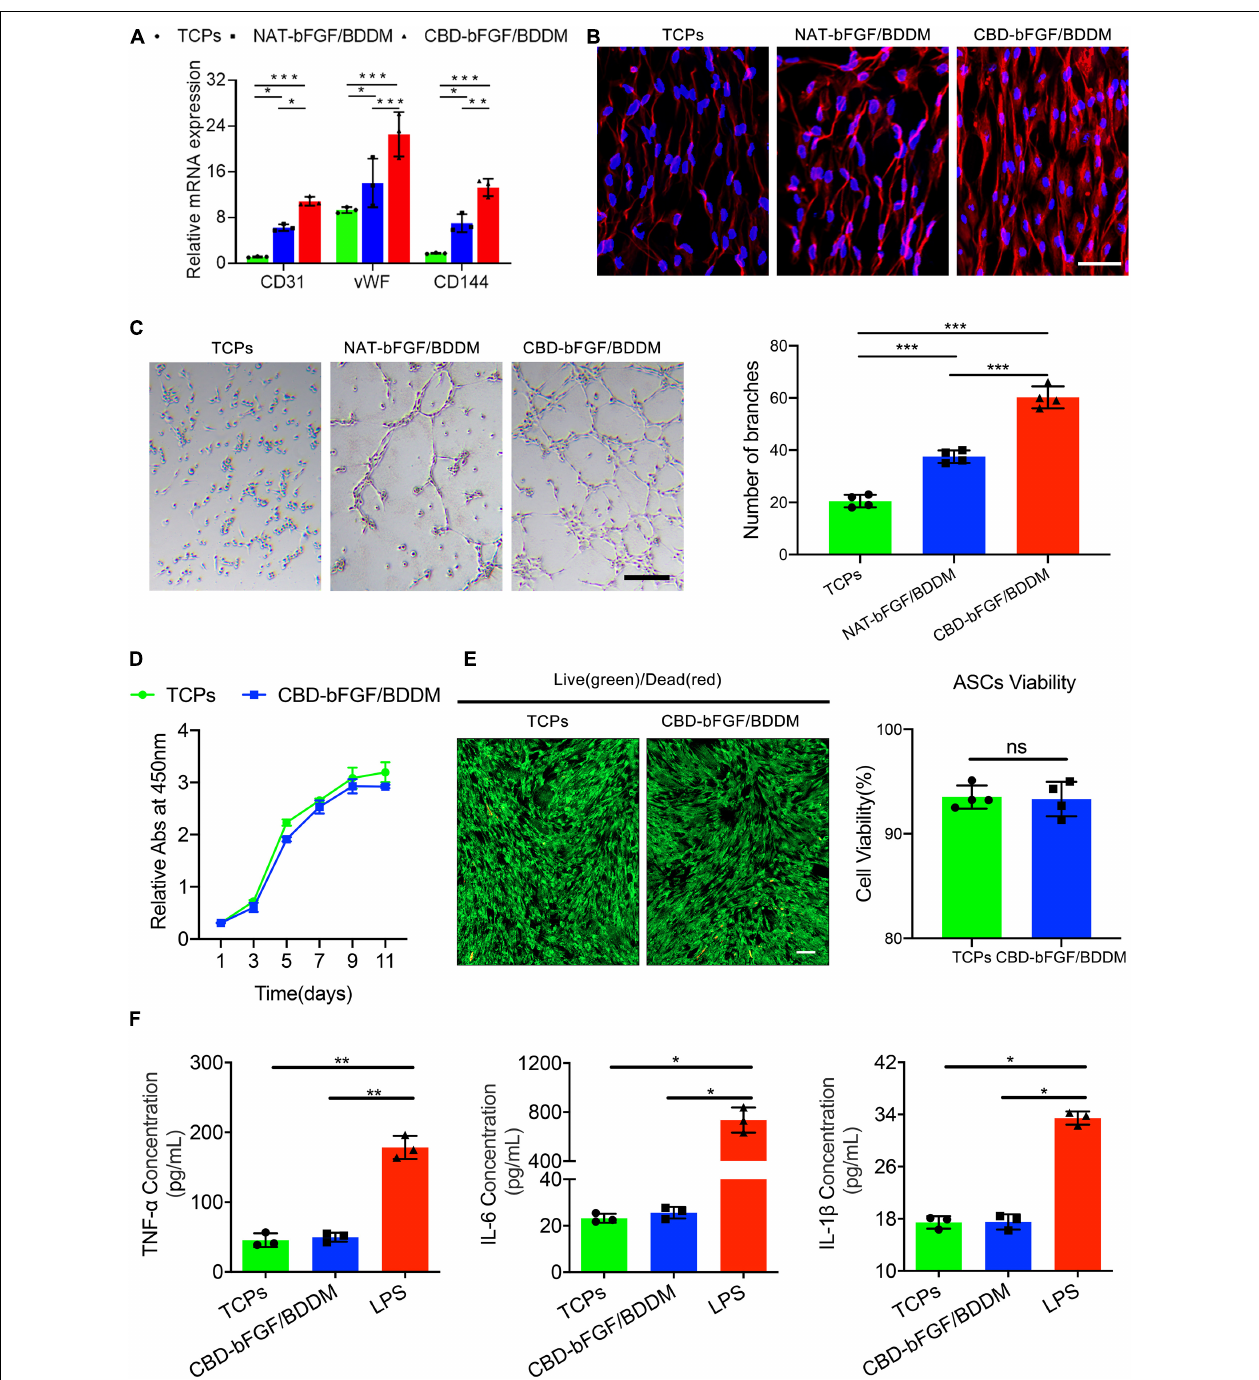
FIGURE 5 | (A) Endothelial cell-specific markers’ (CD31, vWF, and CD144) expression quantified by qRT-PCR demonstrates that natural (NAT)–basic fibroblast growth factor (bFGF)/book-shaped decellularized dermal matrix (BDDM) or collagen-binding domain (CBD)–bFGF/BDDM induced the expression of these endothelial molecular markers. (B) Immunofluorescence staining assays for CD31 expression in the adipose-derived stromal cells (ASCs) cultured with tissue culture polystyrenes (TCPs), NAT-bFGF/BDDM, or CBD–bFGF/BDDM for 10 days. Bar = 50 µ m. (C) Phase-contrast photographs of the differentiated ASCs subsequently plated onto Matrigel for 12 h show more formation of capillary-like structures under the stimulation of CBD–bFGF/BDDM for 10 days. Bar = 100 µ m. (D) Comparative cell proliferation assay of ASCs seeded on the TCPs and CBD–bFGF/BDDM using CCK8 assay ( n = 4). (E) Representative photographs show the live (green) and dead (red) ASCs after culturing with ASCs for 3 days and the viability analysis for the cells on the TCPs and CBD–bFGF/BDDM. Bar = 100 µ m. (F) Pro-inflammatory cytokine (TNF- α , IL-6, and IL-1 β ) secreted by RAW 264.7 in the supernatant of TCPs, CBD–bFGF/BDDM, or lipopolysaccharide group. Data are shown as means ± standard deviation (* P < 0.05, ** P < 0.01, and *** P < 0.001).